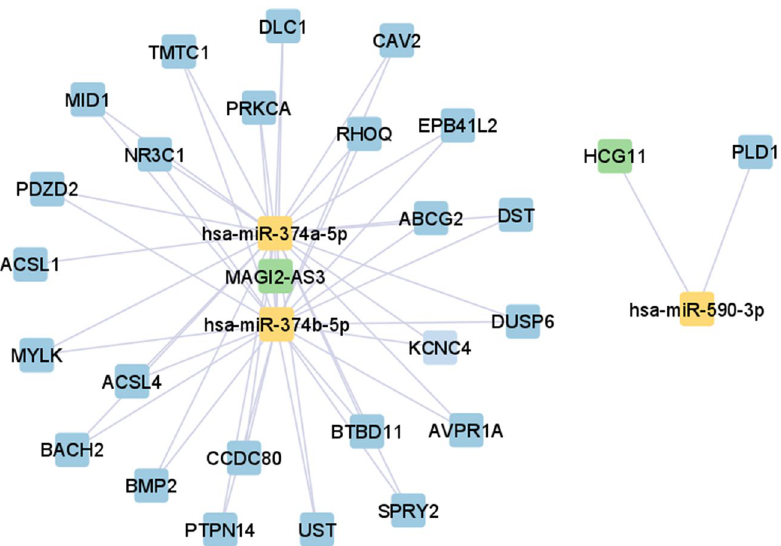
Figure 1. ceRNA network for stage I BC, was constructed by the Cytoscape tool 23 .